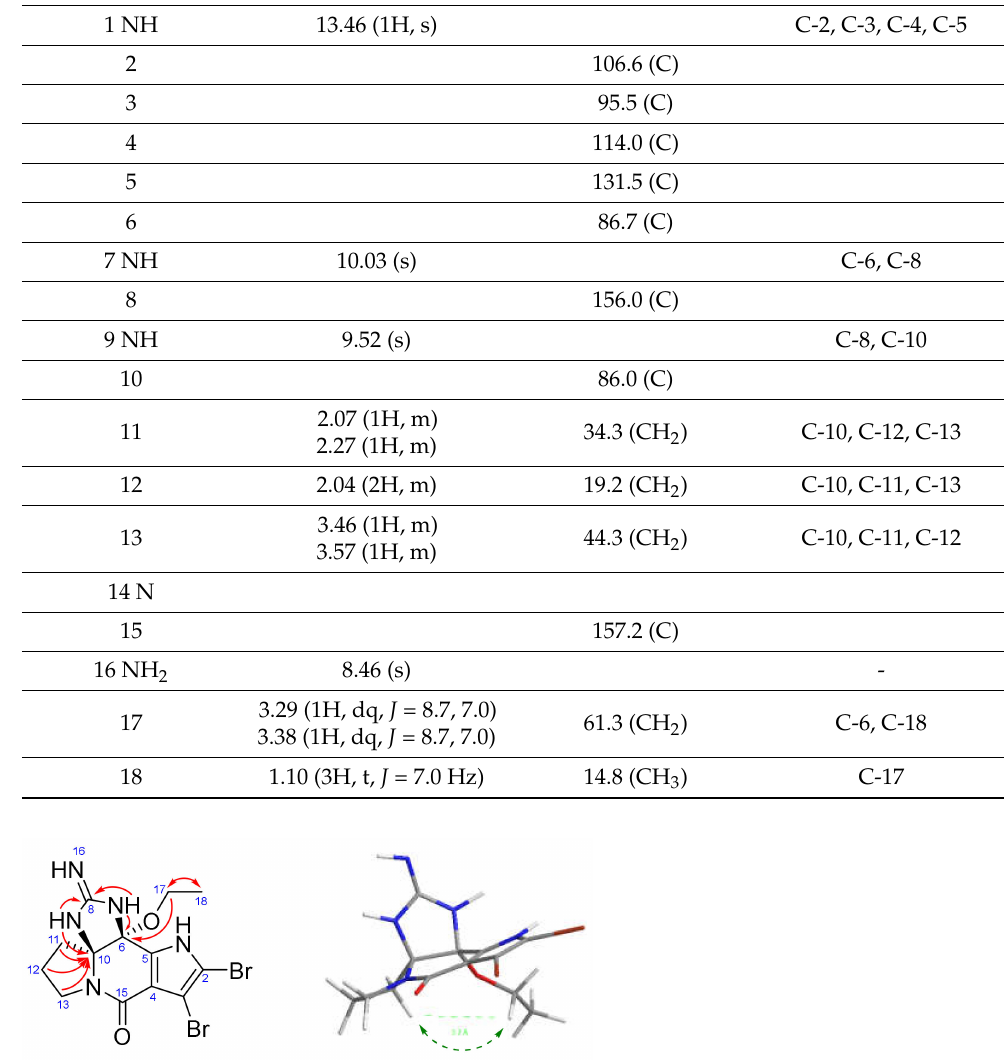
Figure 3. Key HMBC ( ) and 2D-NOESY ( ) correlations of rac -6- O Et-cylindradine A ( 1